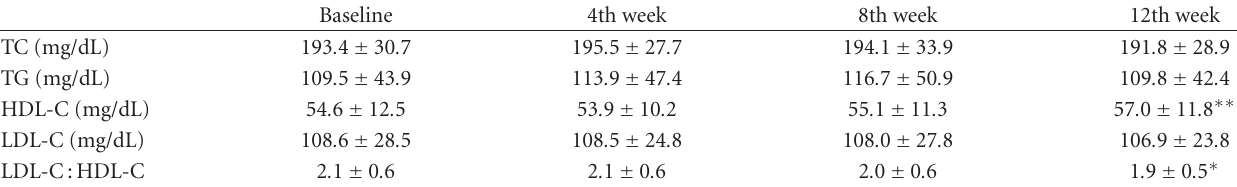
Table 3: Mean ± SD of serum lipid profiles during the